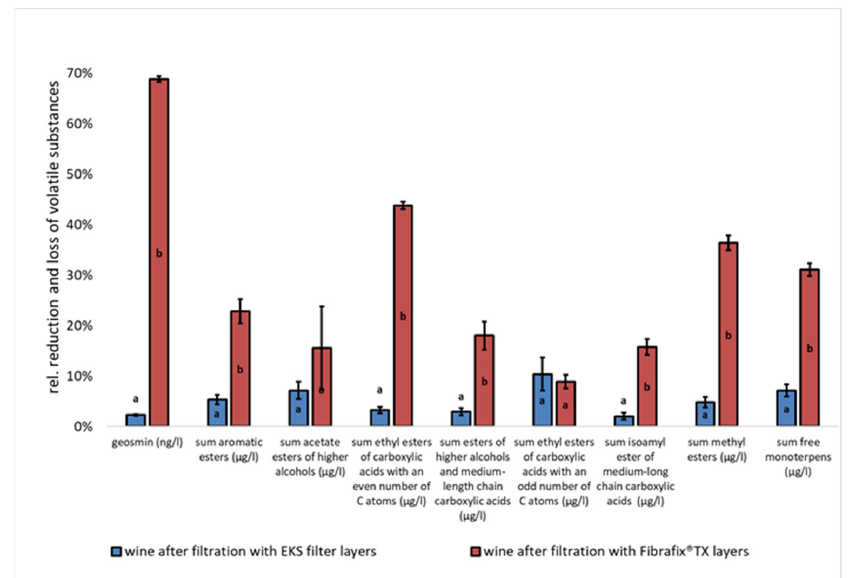
Figure 6. Reduction in geosmin and loss of aroma of ester compounds and free monoterpenes in the large-scale experiment: comparison of the end products after 1250 L filtration capacity per m 2 filter area. Significance test by simple ANOVA. Same letters mean no significant difference based on significance level p ≤ 0.05 with alphabetical order, starting at a (smallest value) to b (largest value).